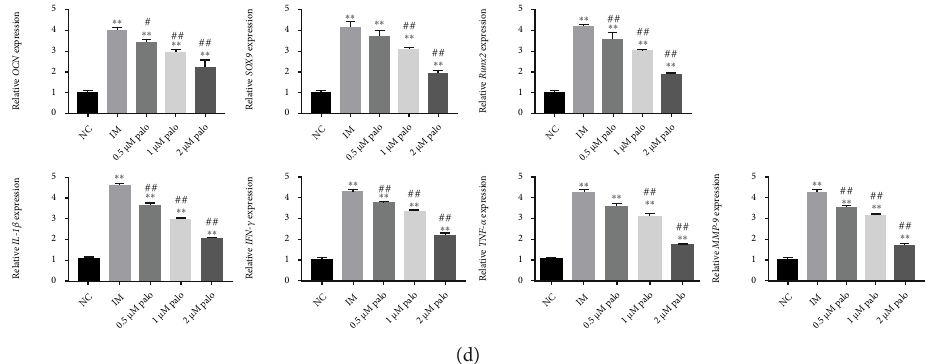
Figure 2: The in fl ammatory microenvironment promotes osteogenic di ff erentiation of TSCs, and palovarotene can in fl uence osteogenesis. (a) CCK8 proliferation assay was used to determine the dose range of palovarotene. Palovarotene at 0.5, 1, and 2 μ M concentration had less e ff ect on TSCs proliferation. Coculture system of activated macrophages and TSCs was constructed. (b) ALP and ARS staining in TSCs after coculture with macrophages. Data are means ± SD ( n = 3 ). ∗ p < 0 : 05 and ∗∗ p < 0 : 01 . # p < 0 : 05 and ## p < 0 : 01 . Scale bar = 50 μ m . (c) Western blot analysis and relevant quantitative analysis of OCN, SOX9, and RUNX2. Data are means ± SD ( n = 3 ). ∗ p < 0 : 05 and ∗∗ p < 0 : 01 . # p < 0 : 05 and ## p < 0 : 01 . (d) The mRNA expression of OCN, SOX9, RUNX2, MMP-9, IL-1 β , IFN- γ , and TNF- α . Data are means ± SD ( n = 3 ). ∗ p < 0 : 05 and ∗∗ p < 0 : 01 . # p < 0 : 05 and ## p < 0 : 01 .